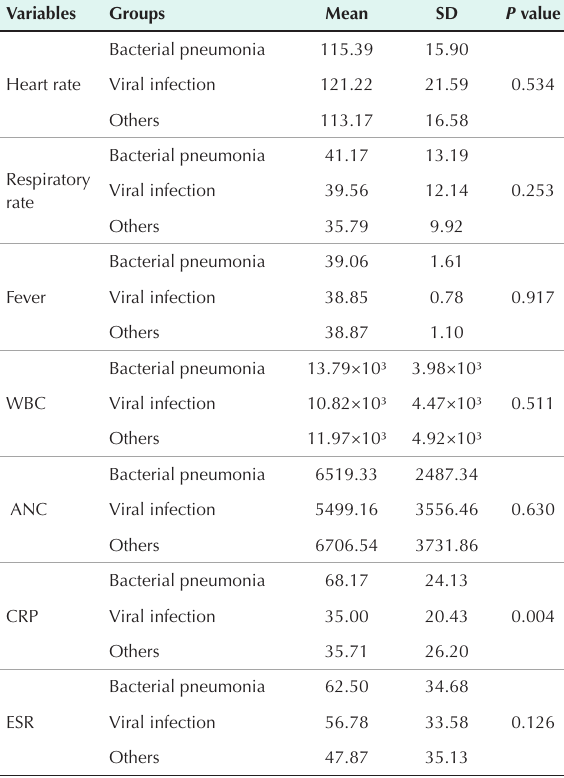
Table 2. The Results of Statistical Test, Mean, and Standard Deviation of Vital Signs and Laboratory Data of Participants Variables